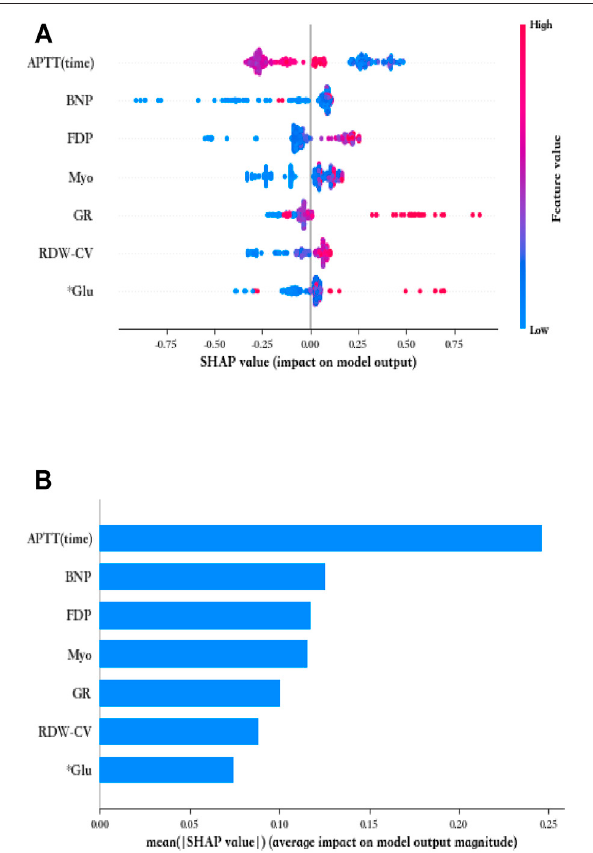
FIGURE 3 | Seven most important variables and their impact on the GBDT model output by SHAP analysis. (A) Summary of SHAP analysis on the data set. One dot represents a case in the data set, and the color of a dot indicatesthevalueofthefeature.Blueindicatesthelowestrangeandred thehighestrange. (B) Rankingofthesevenvariables ’ importanceindicatedby SHAP